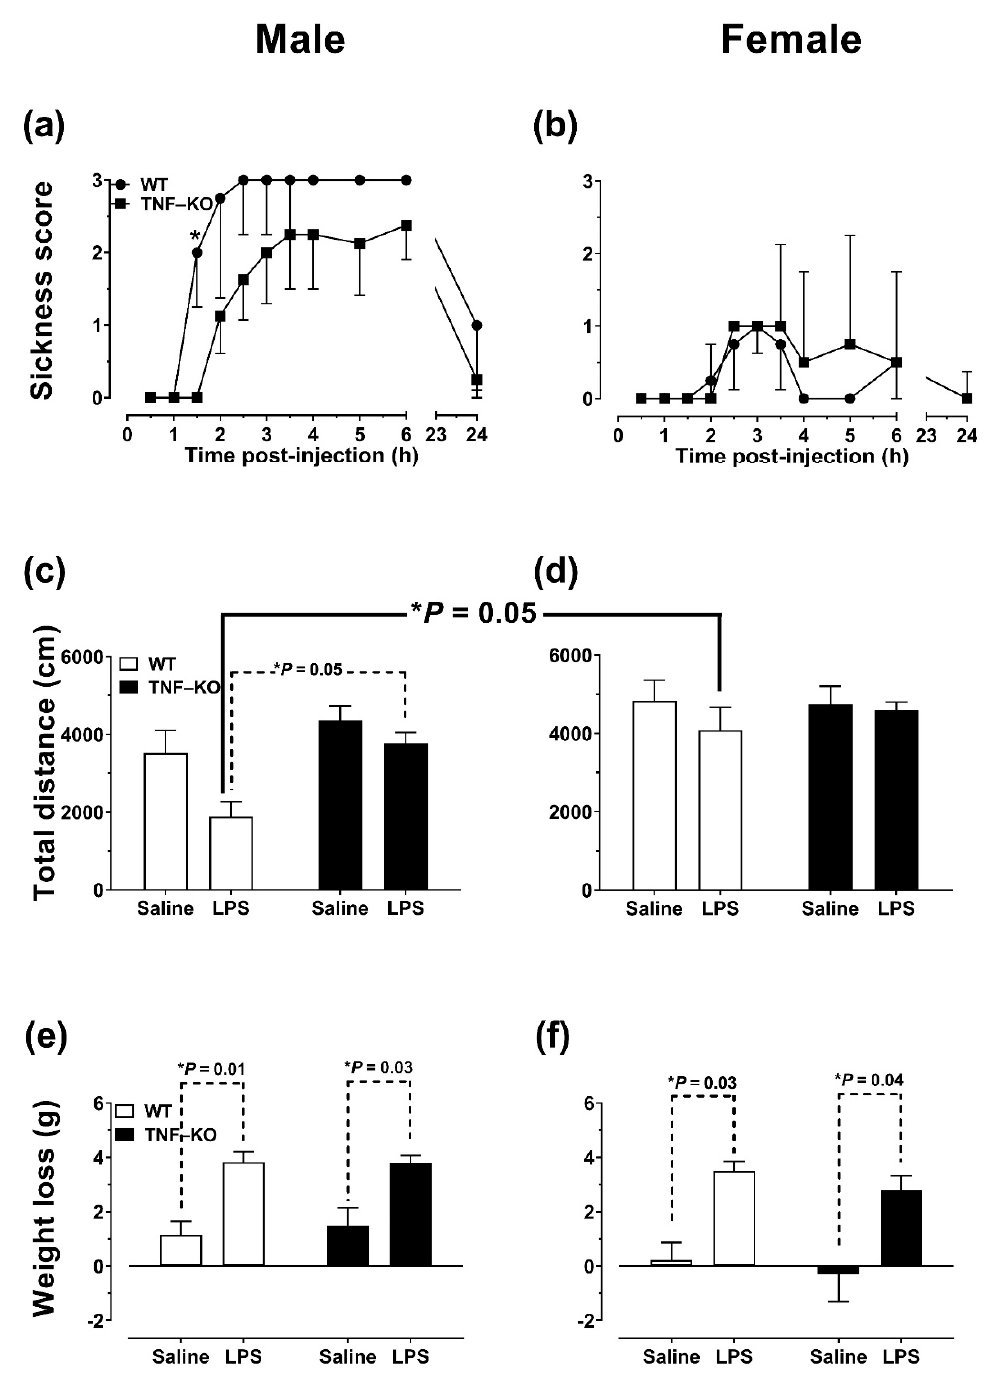
Figure 1. Non-cognitive effects of systemic LPS administration. The effects of 0.5 mg/kg LPS on sickness behavior ( a , b ), total distance travelled ( c , d ) and weight loss ( e , f ) were evaluated 24 h post-injection in male and female WT and TNF-KO mice. ( a , b ) Male mice were more susceptible to LPS-induced sickness behavior compared to females. TNF deletion reduced symptom score in male mice ( a ), an effect that was not observed in females ( b ). Results are presented as the median score ± IQR of n = 4 mice per group, and were analyzed using non-parametric, Mann–Whitney U tests. In ( a ), * p < 0.05 vs. TNF-KO at 1.5 h. ( c , d ) In male mice ( c ), LPS treatment reduced total distance travelled in WT, but not TNF-KO mice, an effect that was not observed in female mice ( d ). Moreover, male, LPS-treated WT mice travelled less than their female counterparts. ( e , f ) Weight was reduced in both male ( e ) and female mice ( f ), irrespective of genotype. Results in c – f are presented as the mean ± SEM of n = 4 mice per group and were analyzed using three-way ANOVA and Bonferroni post hoc tests.